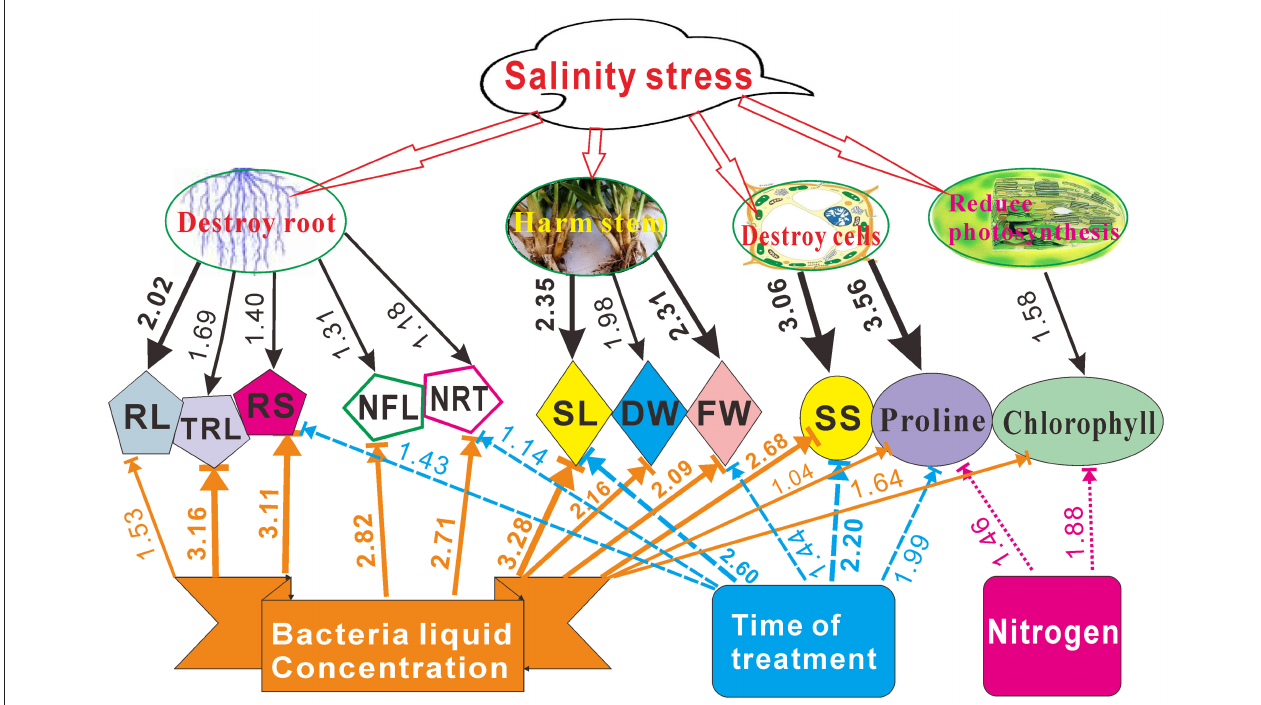
FIGURE 8 | Quantitative estimation of NaCl, the bacterial liquid, treatment time and nitrogen influence on the root length (RL), total root length (TRL), root surface (RS), number of first-order lateral roots (NFL), number of root tips (NRT), shoot length (SL), dry and fresh weigh (DW and FW, respectively), soluble sugar (SS), proline and chlorophyll contents in switchgrass cv. Blackwell based on the variance ratio contributions ( Supplementary Table 7 ). Values < 1.0 are not indicated in this